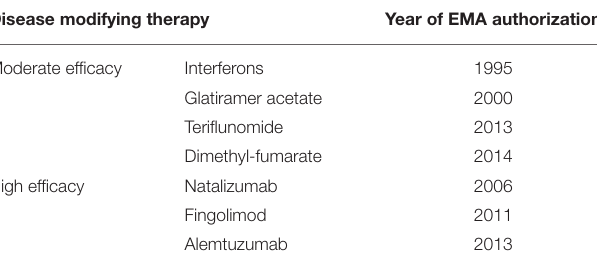
TABLE 1 | Disease modifying therapies and year of European Medical Agency (EMA) approval (http://www.emsp.org/about-ms/ms-treatments/#). Disease modifying